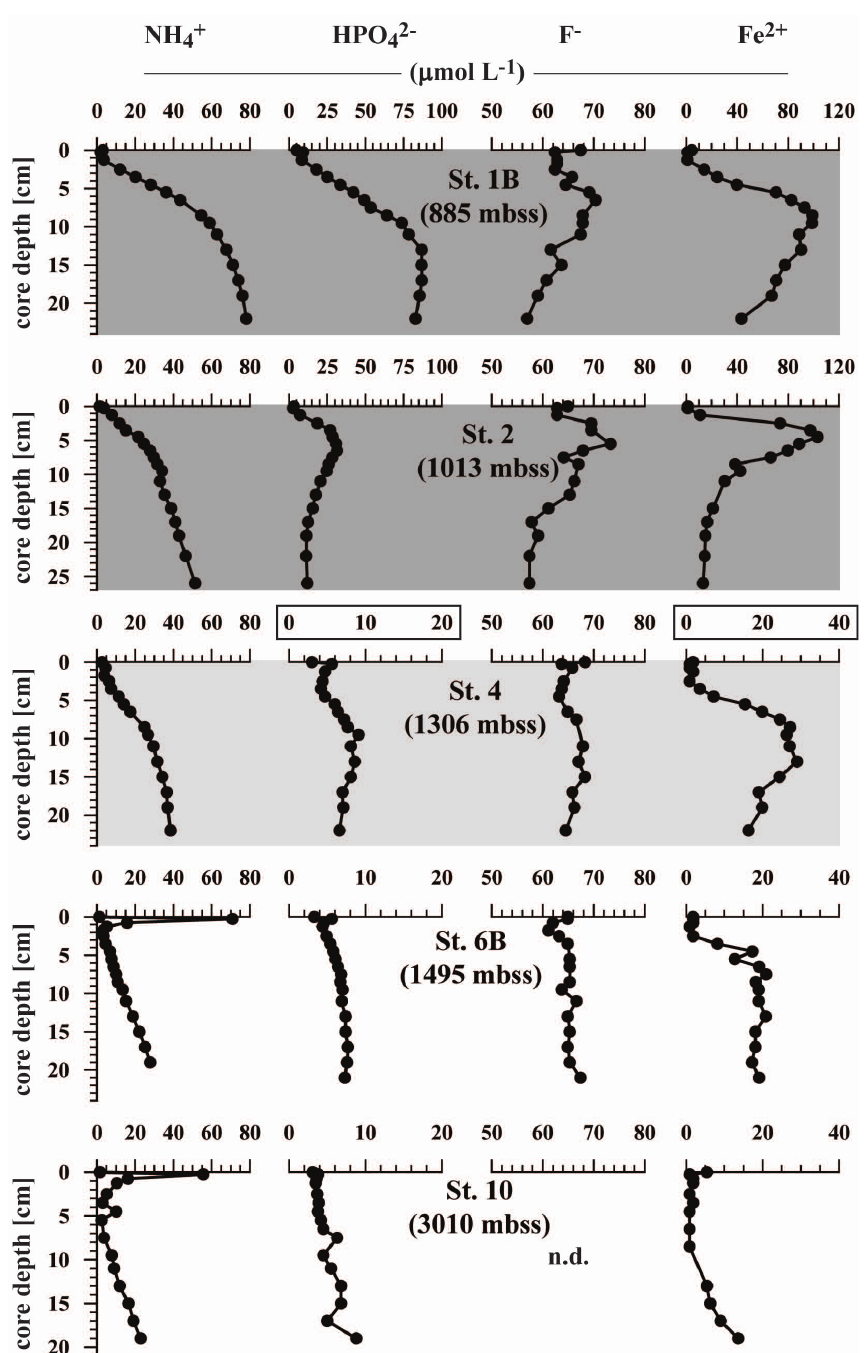
Fig. 4. Pore-water NH + , HPO 2 − , F − and Fe 2 + concentrations in the cores from stations 1B, 2, 4, 6B and 10. Note the different x-axis scale 4 4 for HPO 2 − and Fe 2 + for stations 4, 6B and 10. mbss = meters below sea surface; n.d.=not determined. Dark and light grey fills indicate 4 station position: core of the OMZ, stations 1B and 2 (dark grey), lower boundary of the OMZ, station 4 (light grey). See caption to Fig. 3 for details on OMZ definition. The graphs for stations 6B and 10 below the OMZ have no